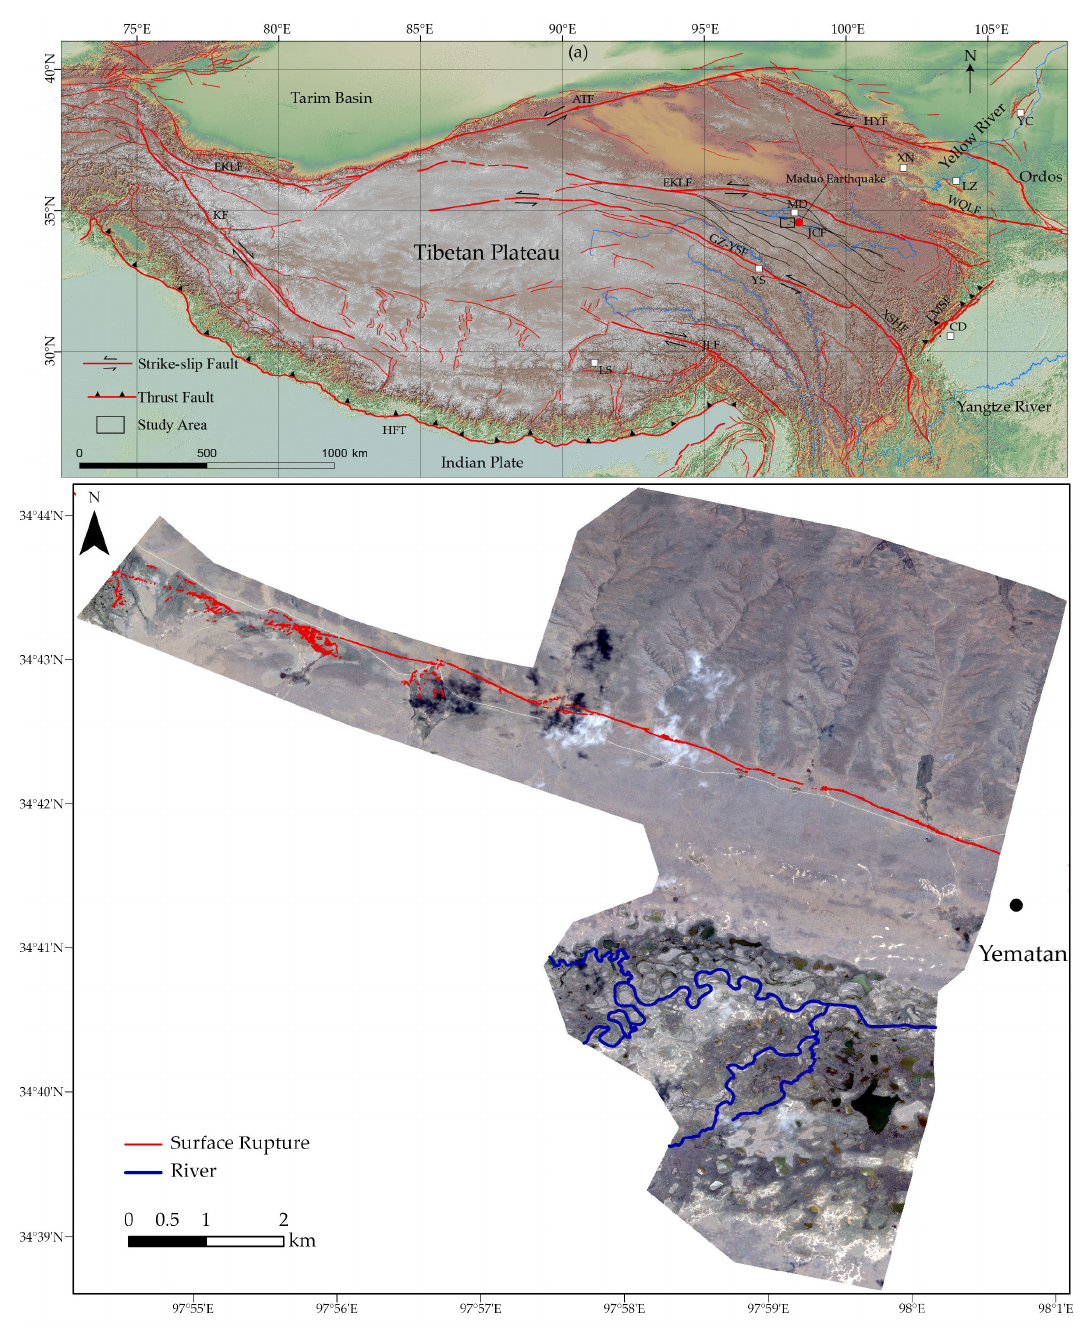
Figure 1. The location and remote sensing images of the study area. ( a ) The tectonic environment around the study area, ( b ) the GF-7 satellite image of the study area the surface rupture data came from [20]. EKLF, Eastern Kunlun Fault; GZ-YSF, Ganzi–Yushu Fault; XSHF, Xianshuihe Fault; LMSF, Longmenshan Fault; WQLF, Western Qinling Fault; JLF, Jiali Fault; JCF, Jiangcuo fault; HYF, Haiyuan Fault; ATF, Altyn Falut; KF, Kunlun Fault; HFT, Himalayan Thrust Fault; SF, Sagaing Fault; MD, Maduo; CD, Chengdu; YC, Yinchuan; LZ, Lanzhou; LS, Lhasa; XN, Xining.